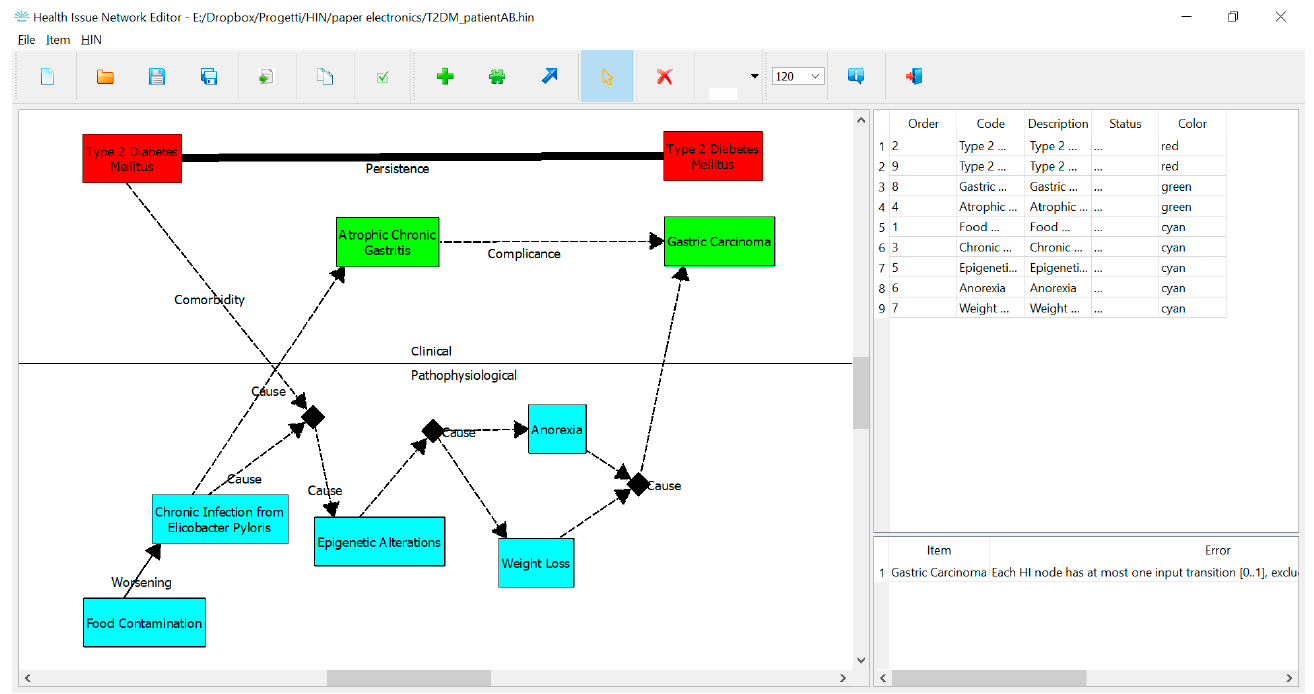
Figure 4. Screenshot of the main application